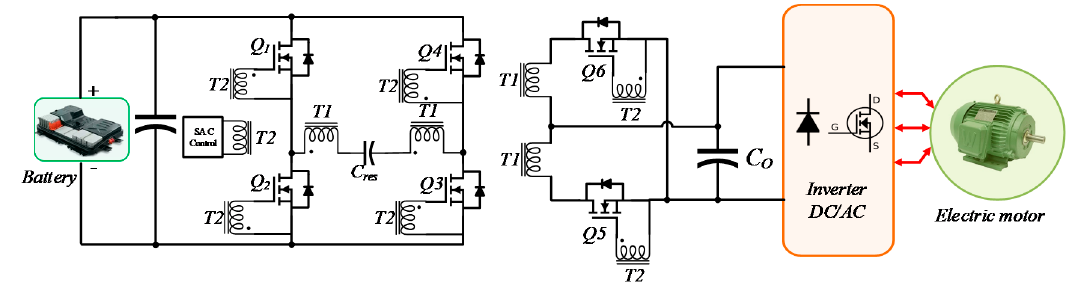
Figure 11. Sinusoidal Amplitude high Voltage bus Converter (T1= Power Transformer and T2= Drive Transformer).